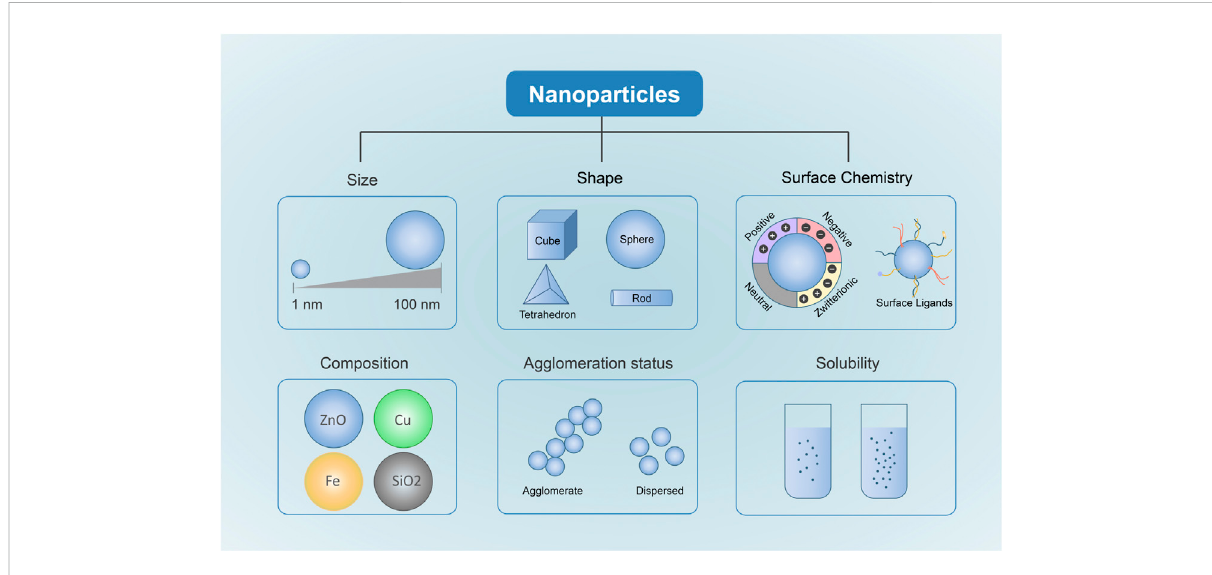
FIGURE 1 Physicochemical Properties Affecting metal-based NP Toxicity. Different Sizes, shapes, chemical compositions, surface chemistry, solubility and agglomeration are closely related to the toxicity induced by metal-based